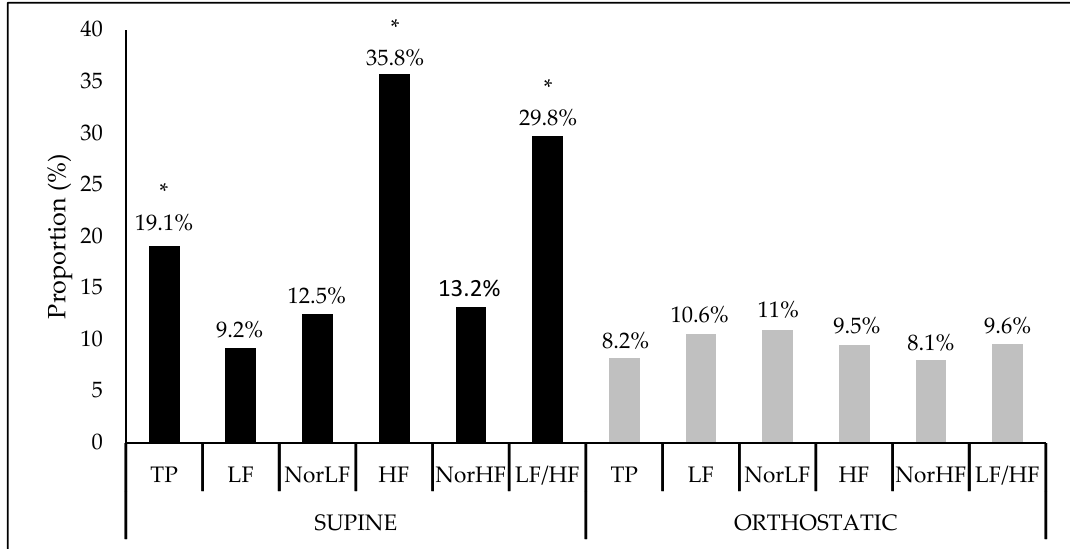
Figure 1. Interference proportion (%) of the crude model apllied at the heart variability índices in the supine and orthostatic position. TP: Total power area; LF: Low frequency; NorLF: Normalized low frequency; HF: High frequency; NorHF: Normalized high frequency; LF/HF: Ratio low frequency/high frequency. * Significance at F < 0.05.